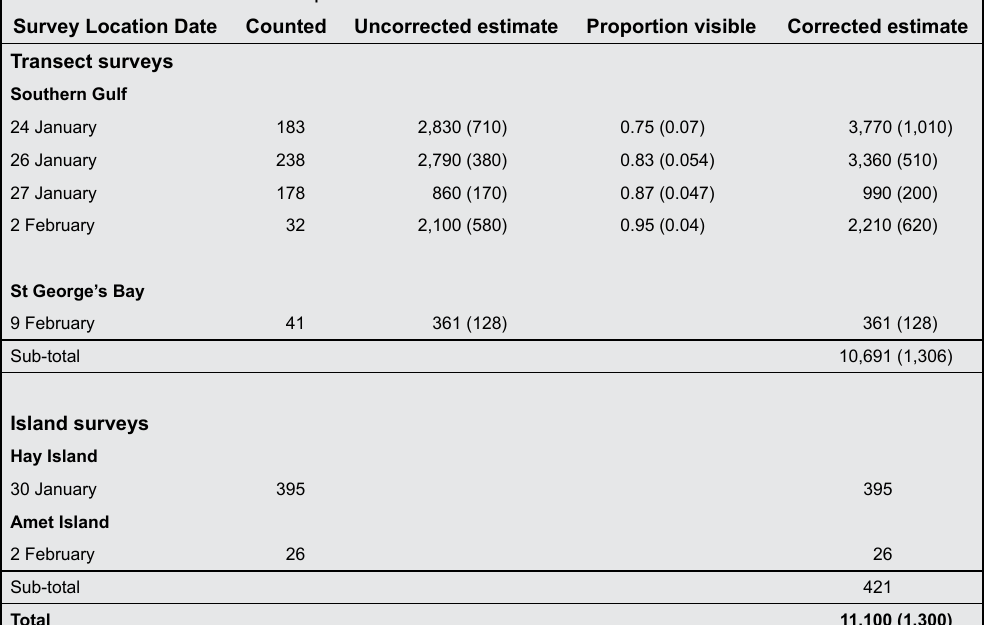
Table 2 . Uncorrected pup production estimates, correction factors and corrected pup production estimates for January and February 1996 surveys. Correction factors were not applied to island counts. Standard errors are in parentheses. The final total is rounded to the nearest